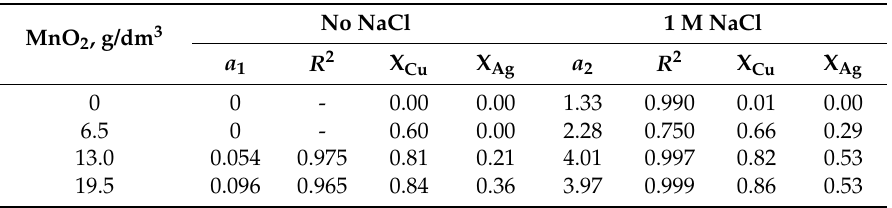
Table 1. Calculated values of the empirical constants a 1 (Equation (17)) and a 2 (Equation (18)), and ultimate dissolutions of copper X Cu and silver X Ag .